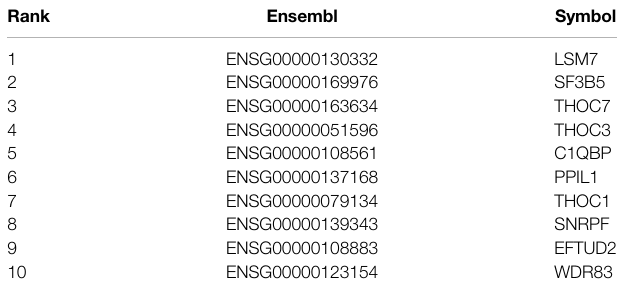
TABLE 2 | Top 10 SFs for degree centrality. TABLE 1 | Clinical characteristics of 493 LUSC patients in the TCGA